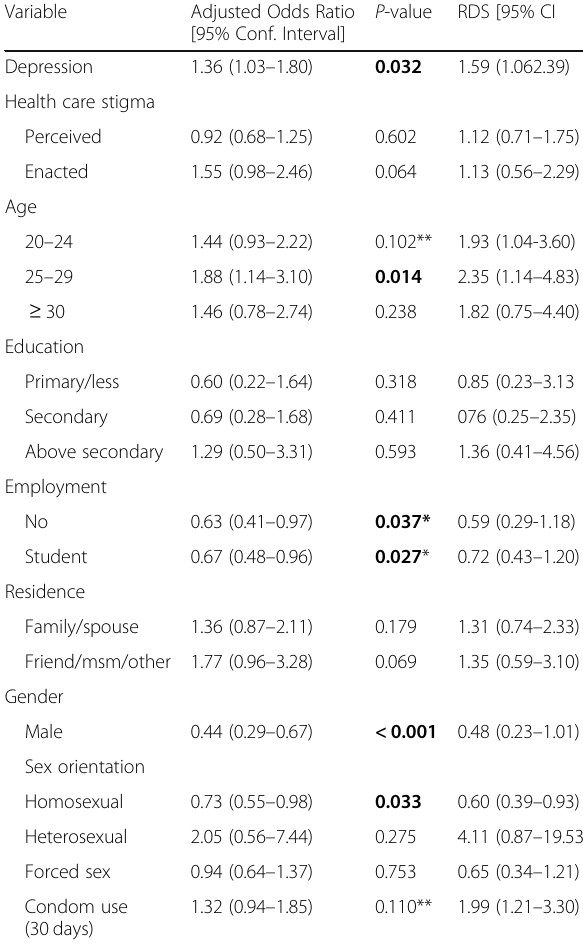
Table 3 Final multivariable model 1: adjusted associations with USHCS Variable